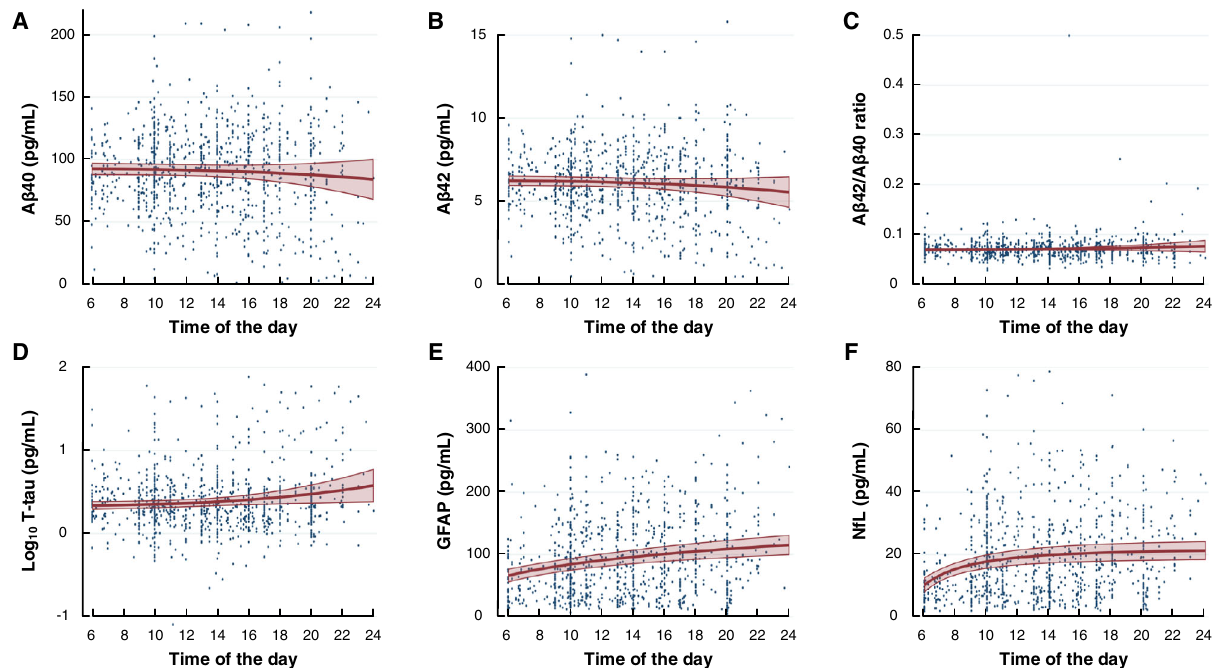
Fig.5|Daytimevariationinplasmabiomarkerconcentrationswithintheentire cohort ( n =106). Biomarker concentrations in longitudinally collected plasma samplesshowednodifferenceovertimefor A A β 40( P =0.348), B A β 42( P =0.185), or C A β 42/ A β 40 ratio ( P =0.309). Increasing plasma concentrations toward eve- ning was shown for D Log 10 T-tau ( P =0.031), E GFAP ( P <0.001), and F NfL